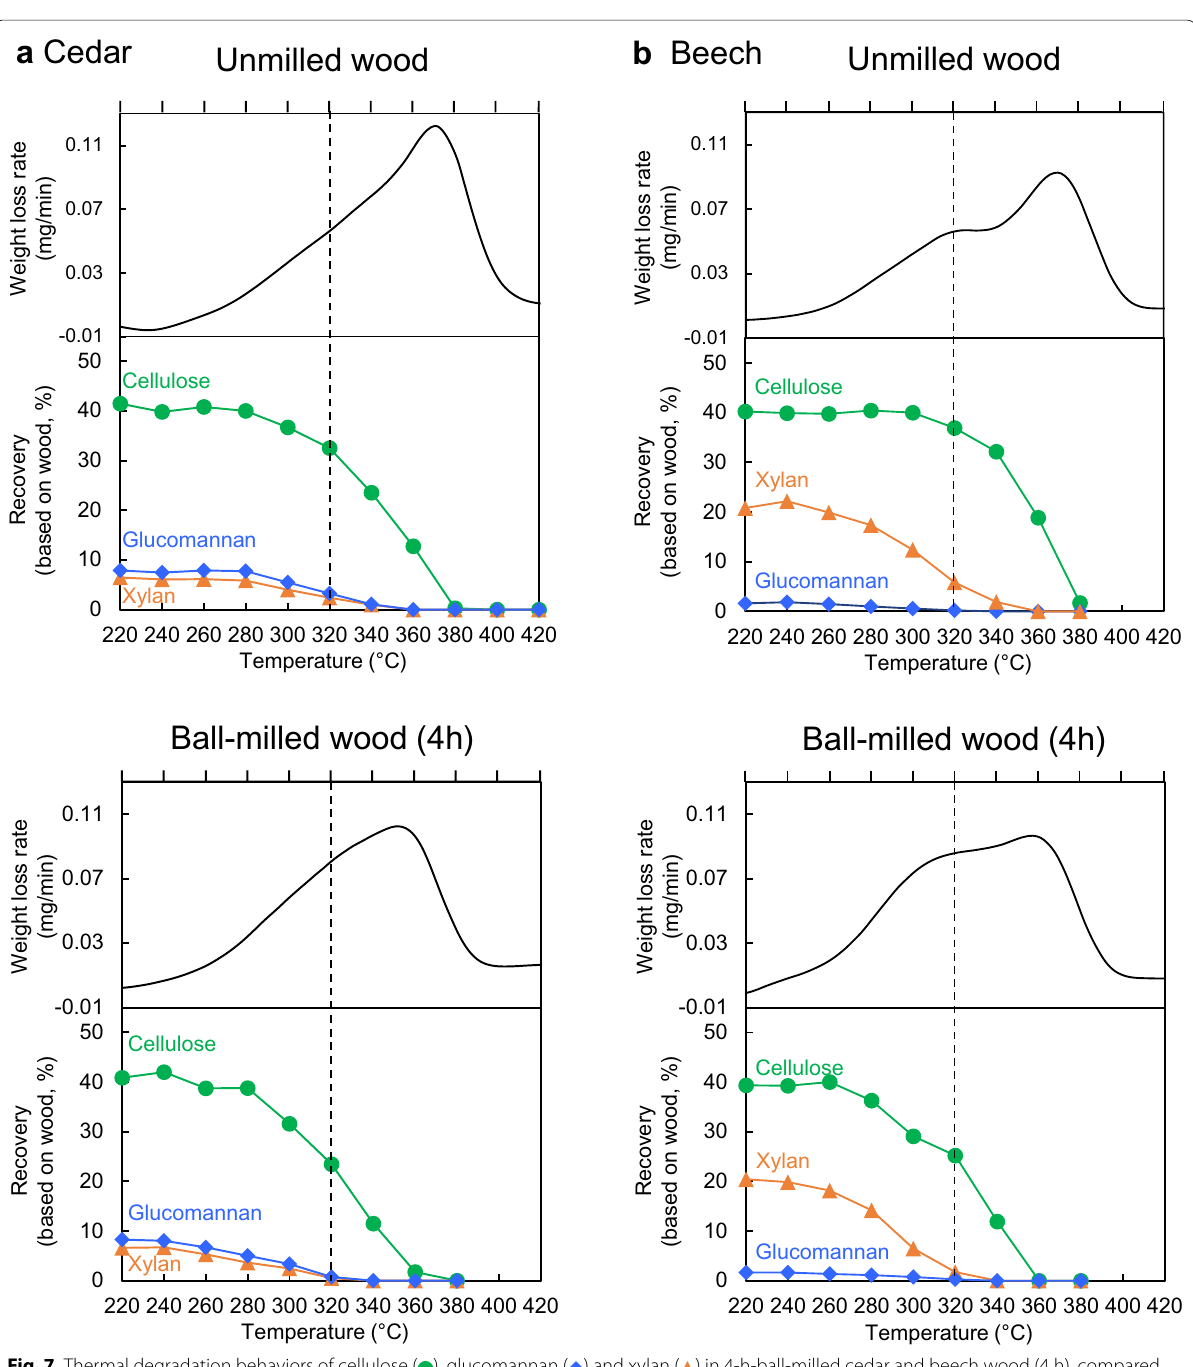
Fig. 7 Thermal degradation behaviors of cellulose ( ), glucomannan ( ) and xylan ( ) in 4-h-ball-milled cedar and beech wood (4 h), compared with the DTG curves. Results of unmilled wood were obtained from Wang et al.